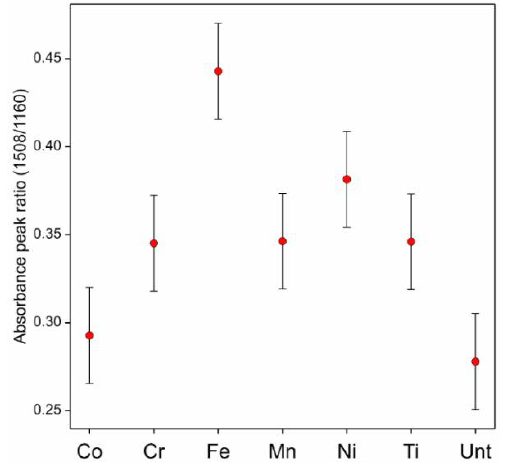
Figure 3. Effects of chemical treatments on the delignification of thin yellow cedar wood veneers exposed to natural weathering for 20 days in Australia: two measurements for each of six veneers per treatment.